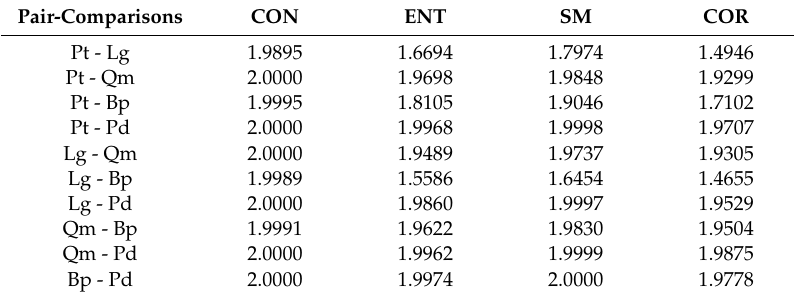
Table 2. The J-M distance among di ff erent forest tree species. The abbreviations of Pt, Lg, Qm, Bp, and Pd stand for tree species Pinus tabulaeformis , Larix gmelinii , Quercus mongolica , Betula platyphylla , and Populus davidiana